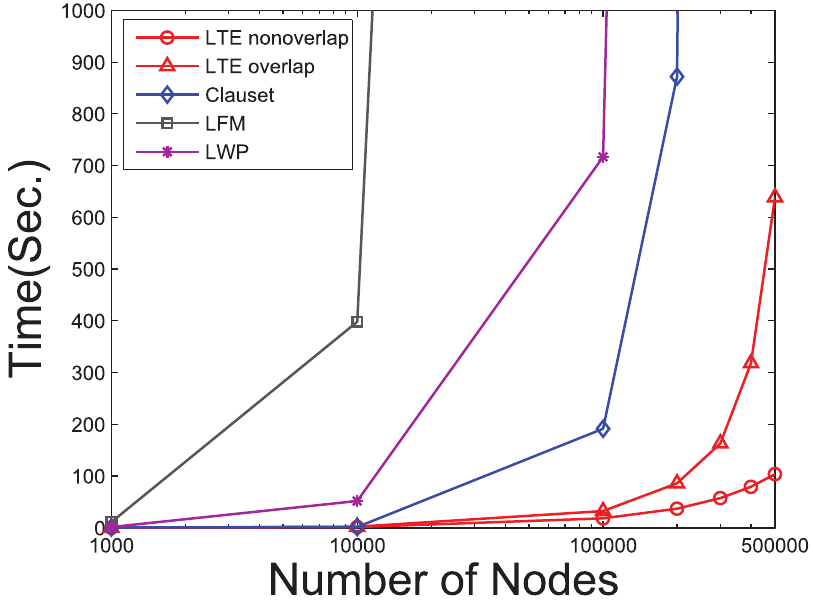
Figure 4. The Zachary’s karate network and four communities discovered by our algorithm on it.